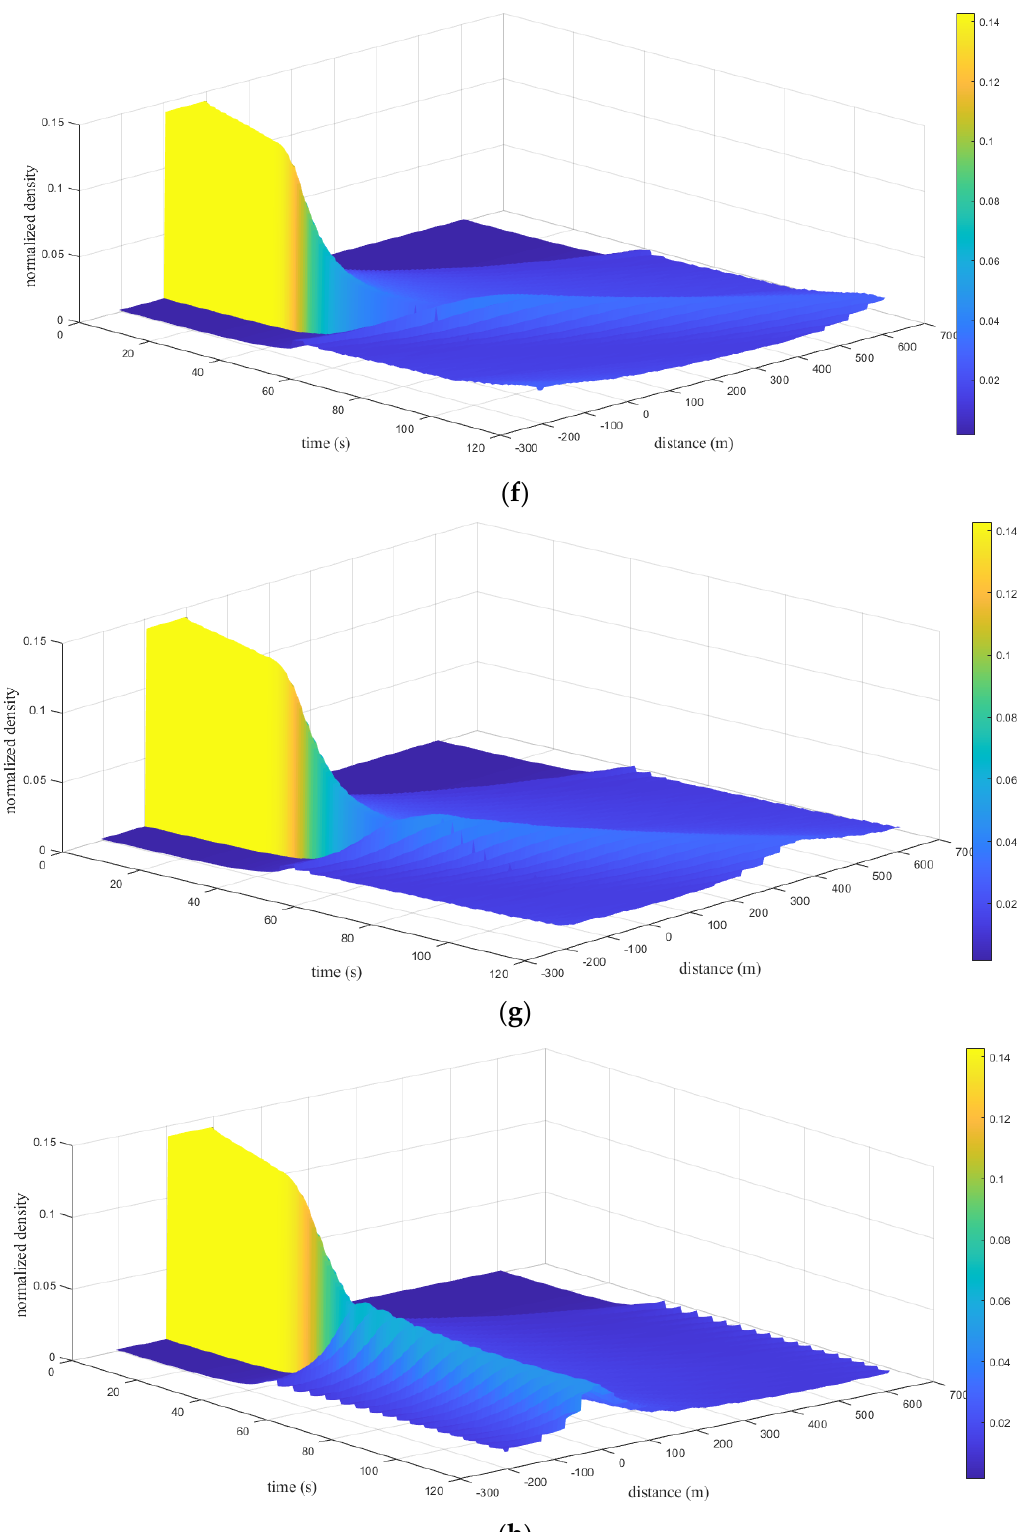
Figure 7. Traffic density with the ID and proposed models over a circular road of length 800 m: ( a ) ID model, 𝛿 = 1 ; ( b ) ID model, 𝛿 = 4 ; ( c ) ID model, 𝛿 = 20 . ( d ) proposed model, 𝑇 = 0.1 s; ( e ) proposed model, 𝑇 = 0.5 s. ( f ) proposed model, 𝑇 = 1 s; ( g ) proposed model, 𝑇 = 1.6 s; ( h ) proposed model, 𝑇 = 2.7 s. For the proposed model with 𝑇 = 0.1 s, the density at 0 m was 0.03 at 119.5 s. It de- creased to 0.01 at 466.2 m and then to 0.009 at 559.4 m as shown in Figure 7d. The den- sity at 0 s between −96.5 m and −3.3 m was 0.14 and was constant up to 120 s at −109